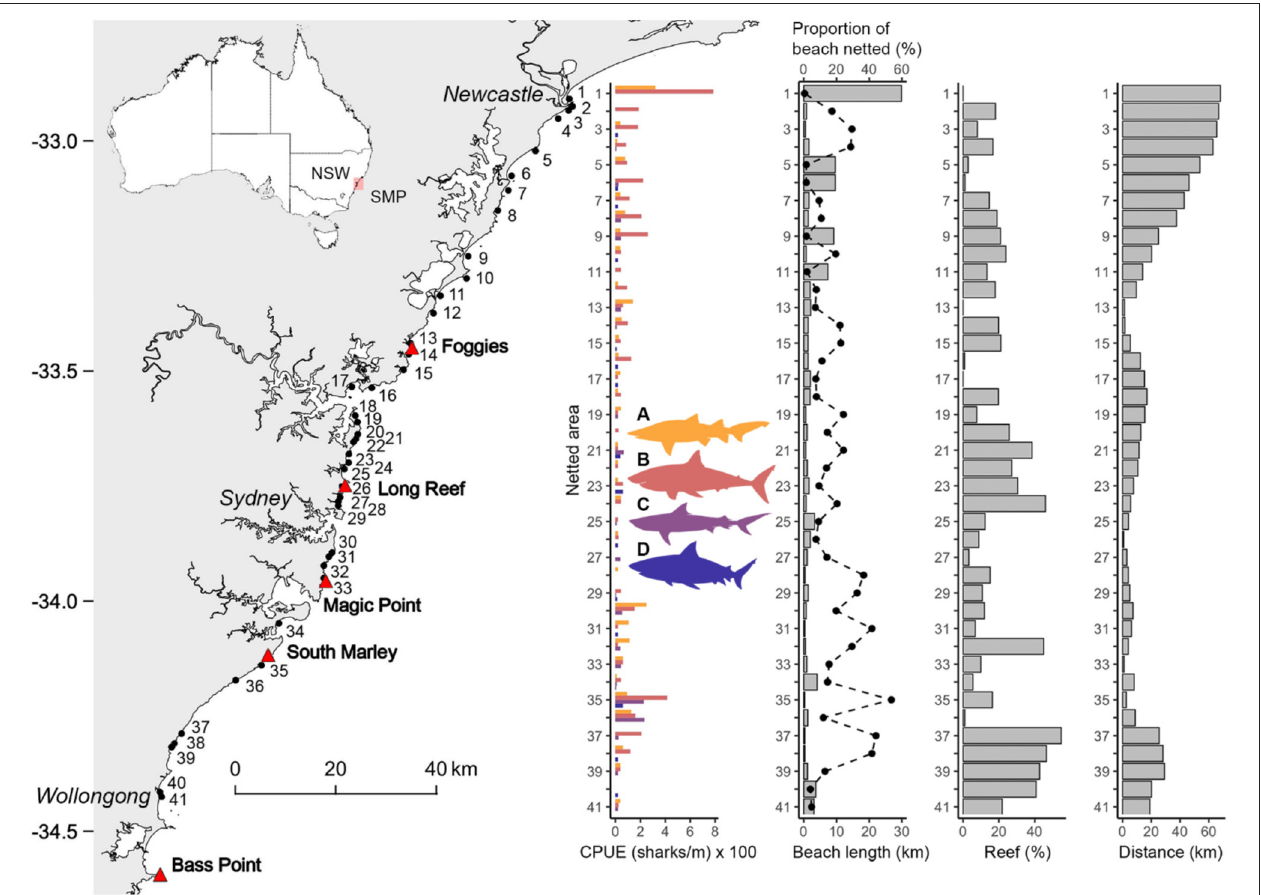
FIGURE 1 | Map of the area covered by the Shark Meshing Program (SMP) showing the locations of the known aggregation sites of grey nurse sharks (triangles) and the 41 netted areas (circles), including total catch-per-unit-of-effort (CPUE) of (A) grey nurse, (B) white, (C) tiger, and (D) bull sharks between September 1998 and April 2019. The distributions of the physical parameters beach length, proportion of beach netted, percentage of reef area (Reef), and their corresponding distance from the nearest grey nurse shark aggregation site (Distance) are also